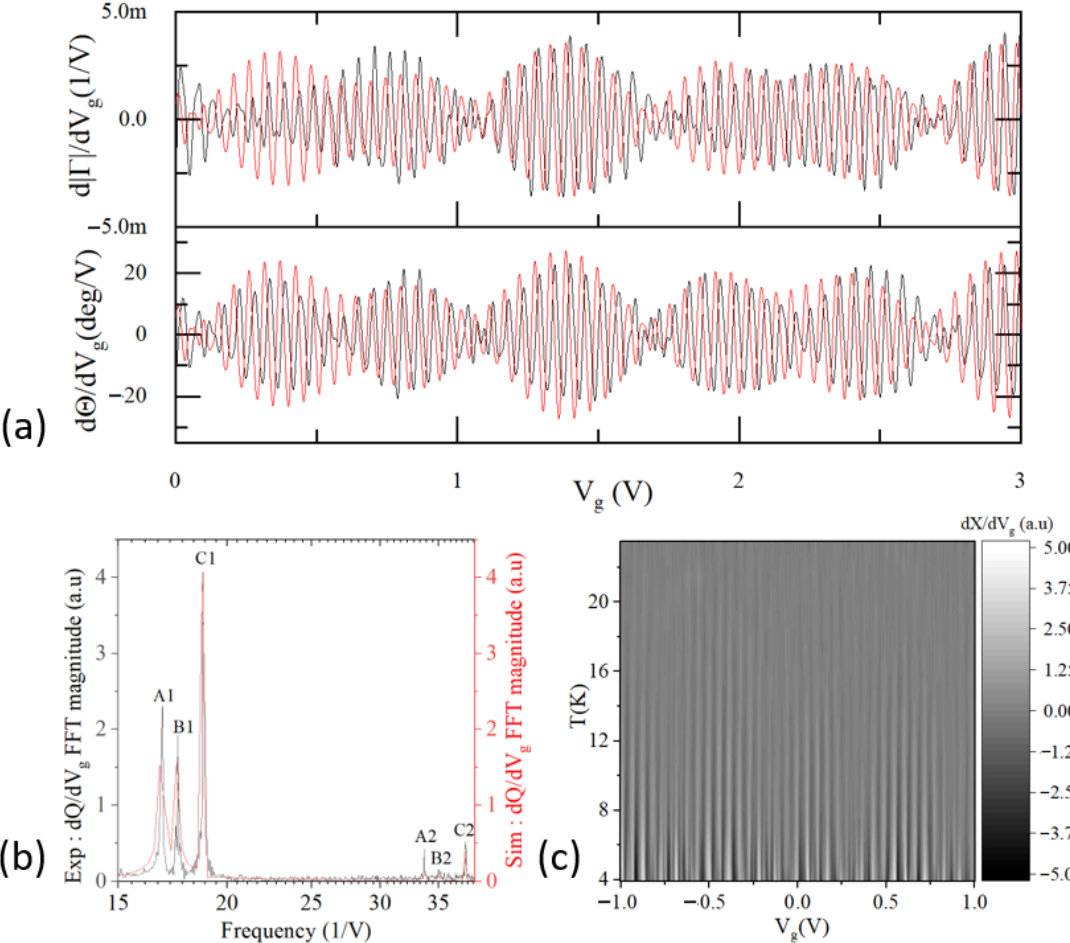
Figure 11. ( a ) Oscillations of derivatives d | Γ |/ dV g and phase d Θ / dV g vs. voltage of sensing gate V g of the 3 SEB array at 11.5 K superimposed with simulations. Black—experiment, red—simulations. ( b ) FFT of d Θ / dV g data over 16 V V g span (black) along with the spectrum of simulated data (red in Figure 11a). ( c ) Oscillations of the derivative dRe( Γ ) / dV g vs. V g acquired at di ff erent temperatures (from 3.9 to 23.5 K).